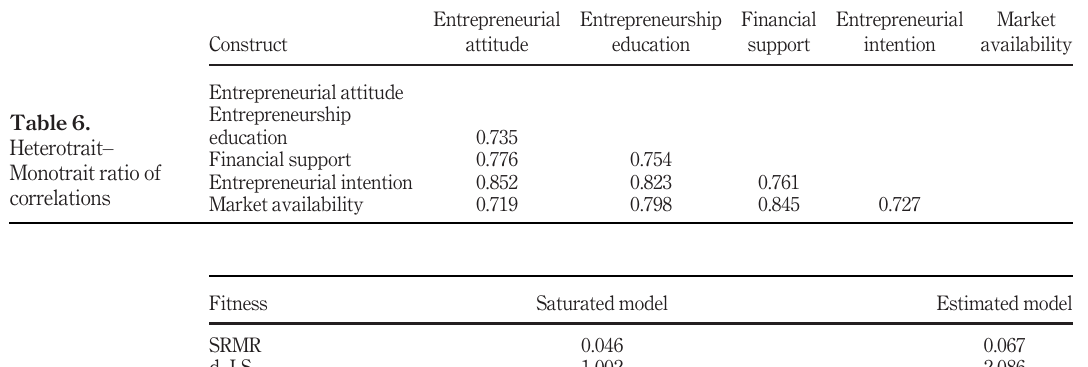
Table 7. Fit summary